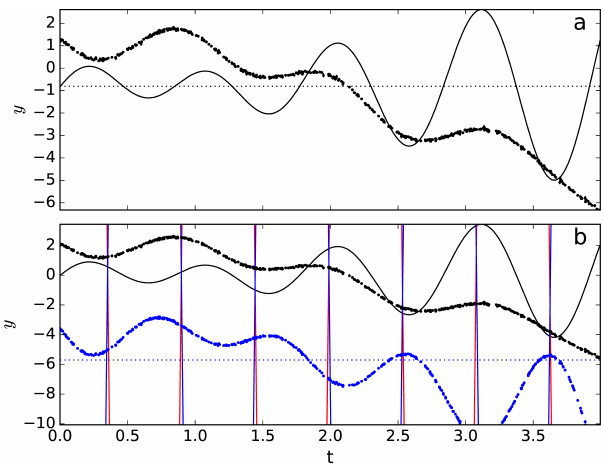
Fig. 9.— Model 9 for Table 3 data. Otherwise as in Fig. 3